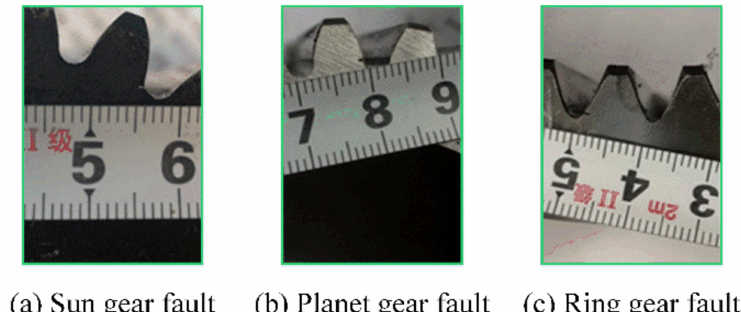
Figure 8. The faults of the